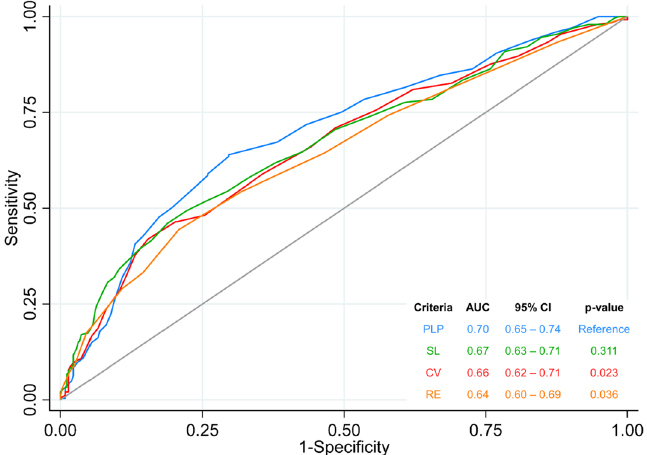
Figure 2. ROC curve and AUC for all ECG evaluated criteria. AUC of the ECG criteria, using the echocardiogram as the reference for LVH. All criteria were compared against the Peguero-Lo Presti criterion. AUC area under the curve; CI Confidence Interval; Ref reference.